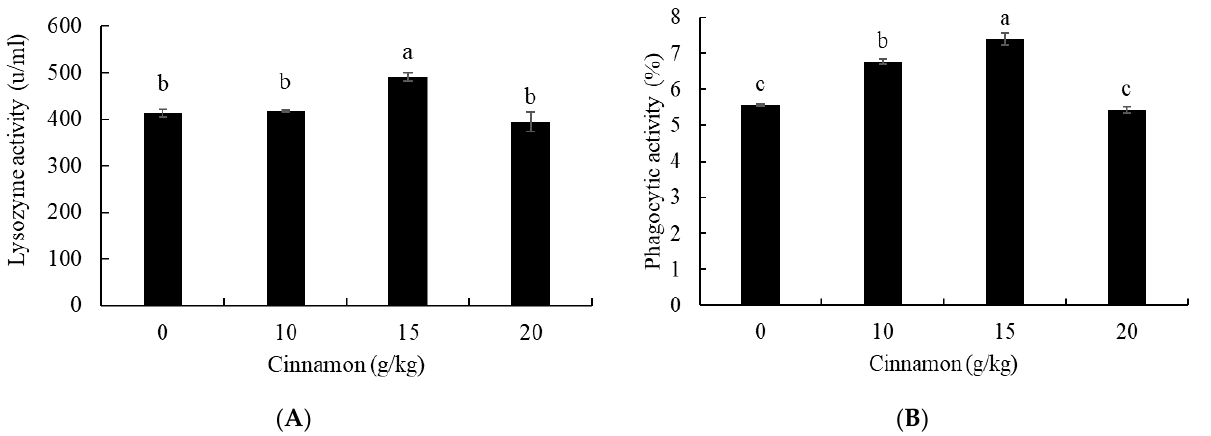
Figure 3. Blood lysozyme ( A ) and phagocytic ( B ) activities of European sea bass fed dietary cinnamon. Bars with different letters are significantly different ( p < 0.05).